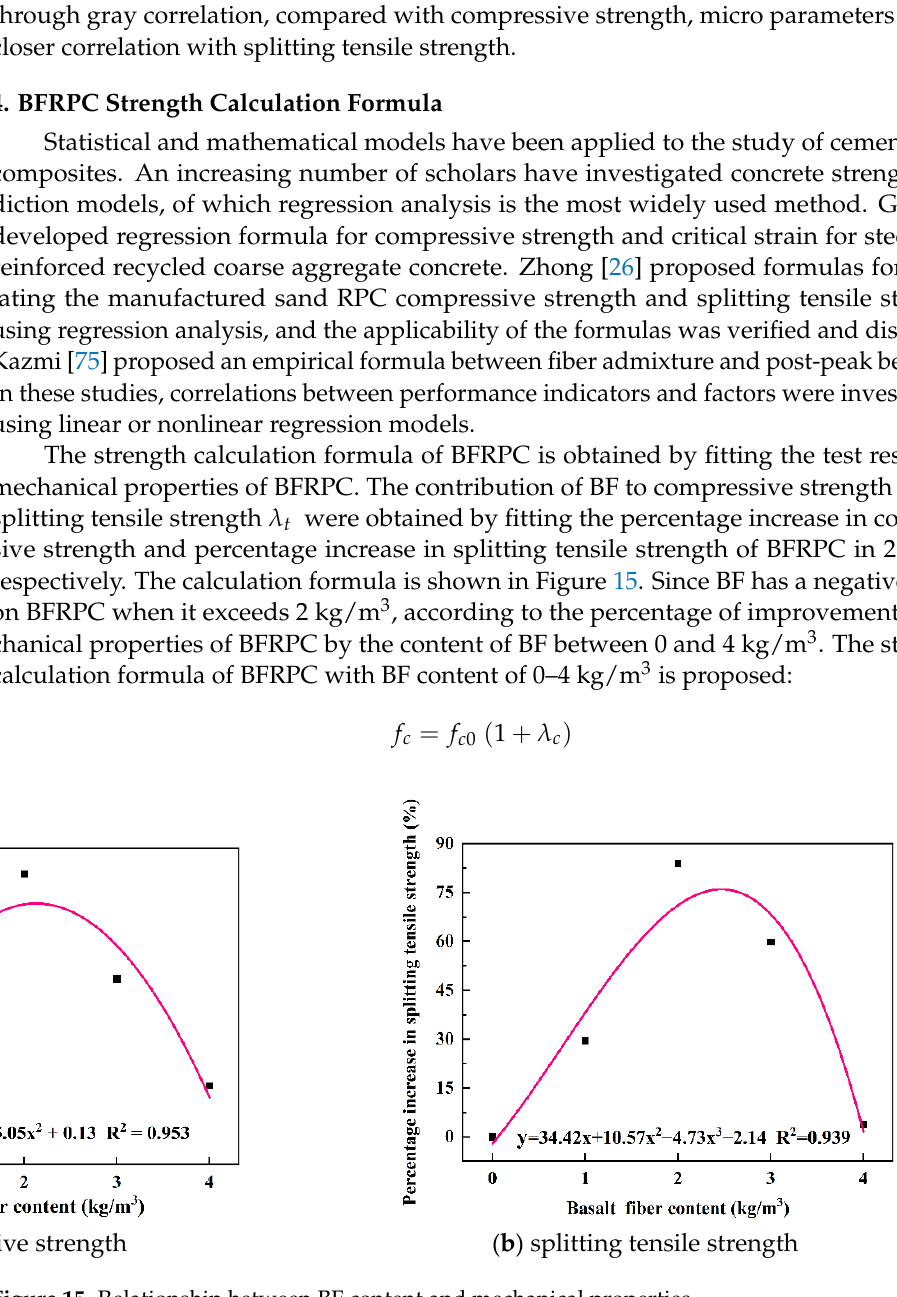
Figure 15. Relationship between BF content and mechanical